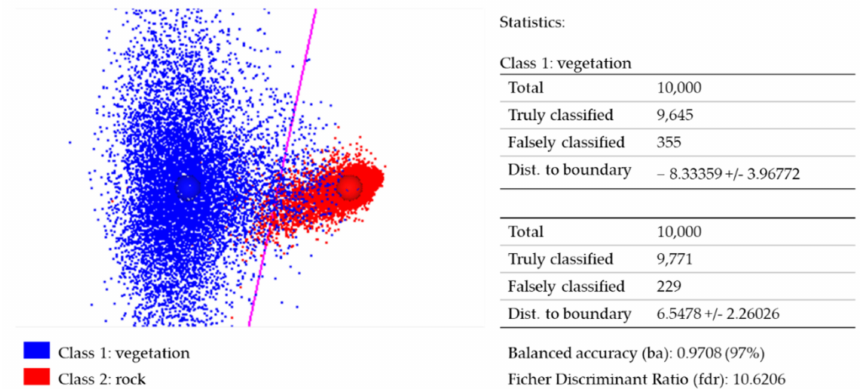
Figure 6. Stratigram with classifier definition in the plane of maximum separability between points belonging to the two categories, vegetation samples (blue) and rock (red). Overall balanced accuracy is